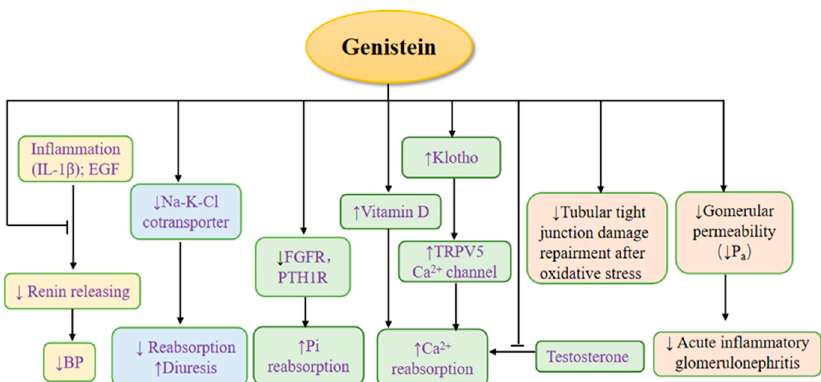
Figure 3. The effects of genistein on kidney physiology. IL-1 β : interleukin-1 beta; BP: blood pressure; FGFR: fibroblast growth factor receptor; PTH1R: parathyroid hormone 1 receptor; TRPV5: transient receptor potential vanilloid 5; Pa: albumin permeability, ↓ : inhibit; ↑ : upregulate.